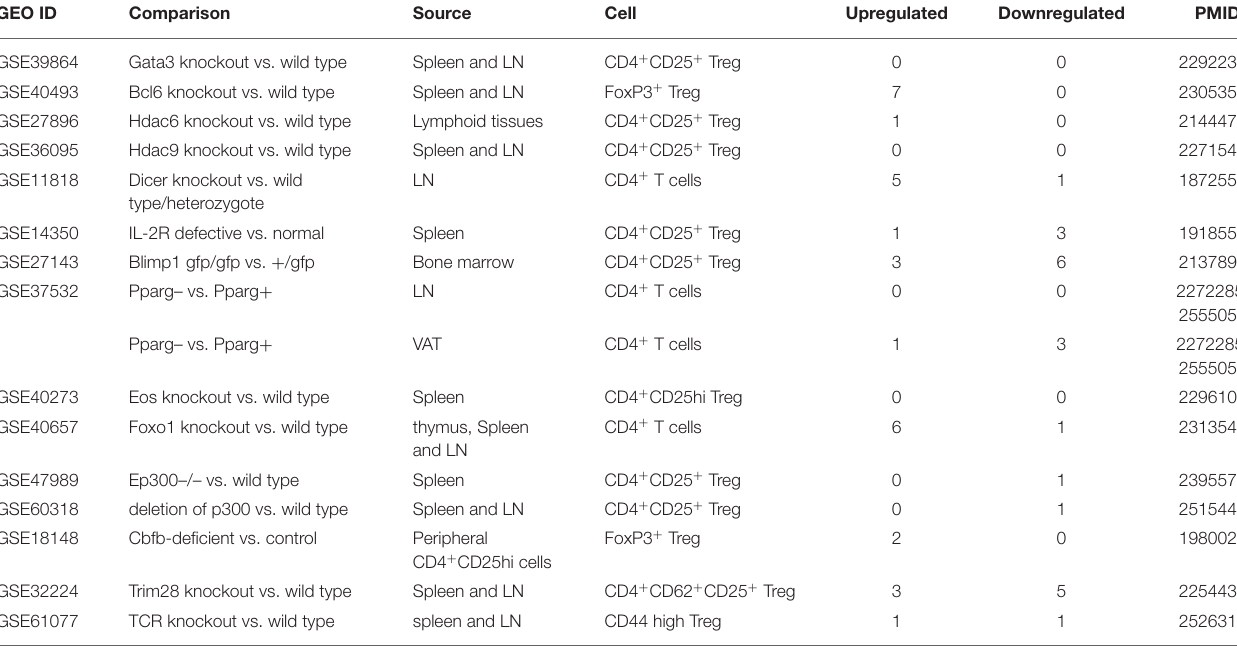
TABLE 6 | Fifteen microarrays of regulatory T cell regulator deficiency in the National Institutes of Health (NIH)–National Center for Biotechnology Information (NCBI)–Gene Expression Omnibus (GEO) datasets database (https://www.ncbi.nlm.nih.gov/gds/) were collected to analyze the expression changes of OCRGs ( p < 0.05, |logFC| > 1). GEO ID